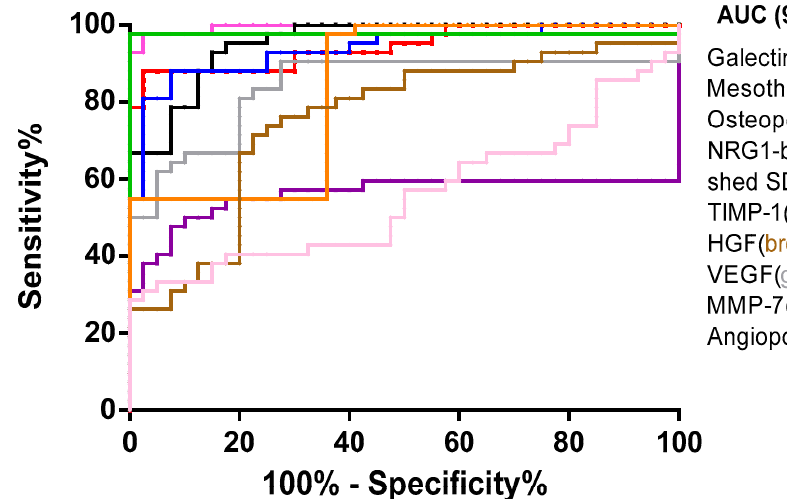
Figure 7. Diagnostic efficiency of individual biomarkers. Receiver operating characteristic (ROC) analysis showing the specificity and sensitivity for each individual angiogenesis related biomarkers. Area under the curve (AUC) values show that Galectin-1 (AUC = 0.99), NRG1- β 1 (AUC = 0.97), Osteopontin (AUC = 0.95), Mesothelin (AUC = 0.94) and shed SDC-1(AUC = 0.93) have the most diagnostic value for malignant pleural mesothelioma.